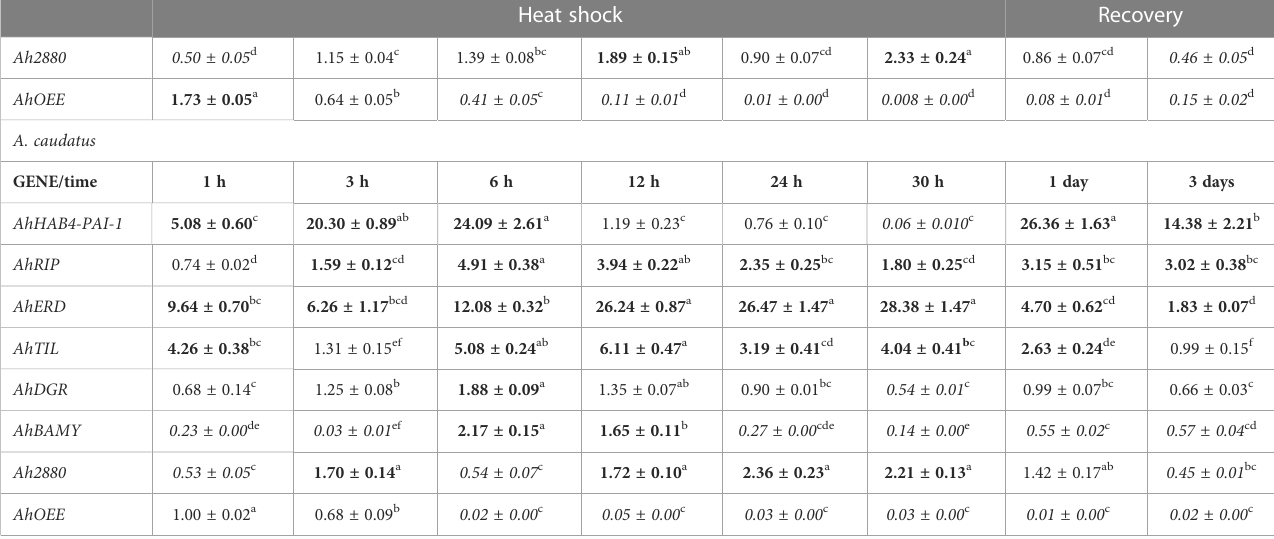
Most biochemical responses activated in response to heat stress shared a certain degree of similarity in A. hypochondriacus and A. cruentus and tended to differ, in some cases notably, in A. caudatus . Glucose (Glc) levels were reduced ca. 2 to 10-fold in heat-shocked A. hypochondriacus and A. cruentus plants (Figure 3A). The decrease in